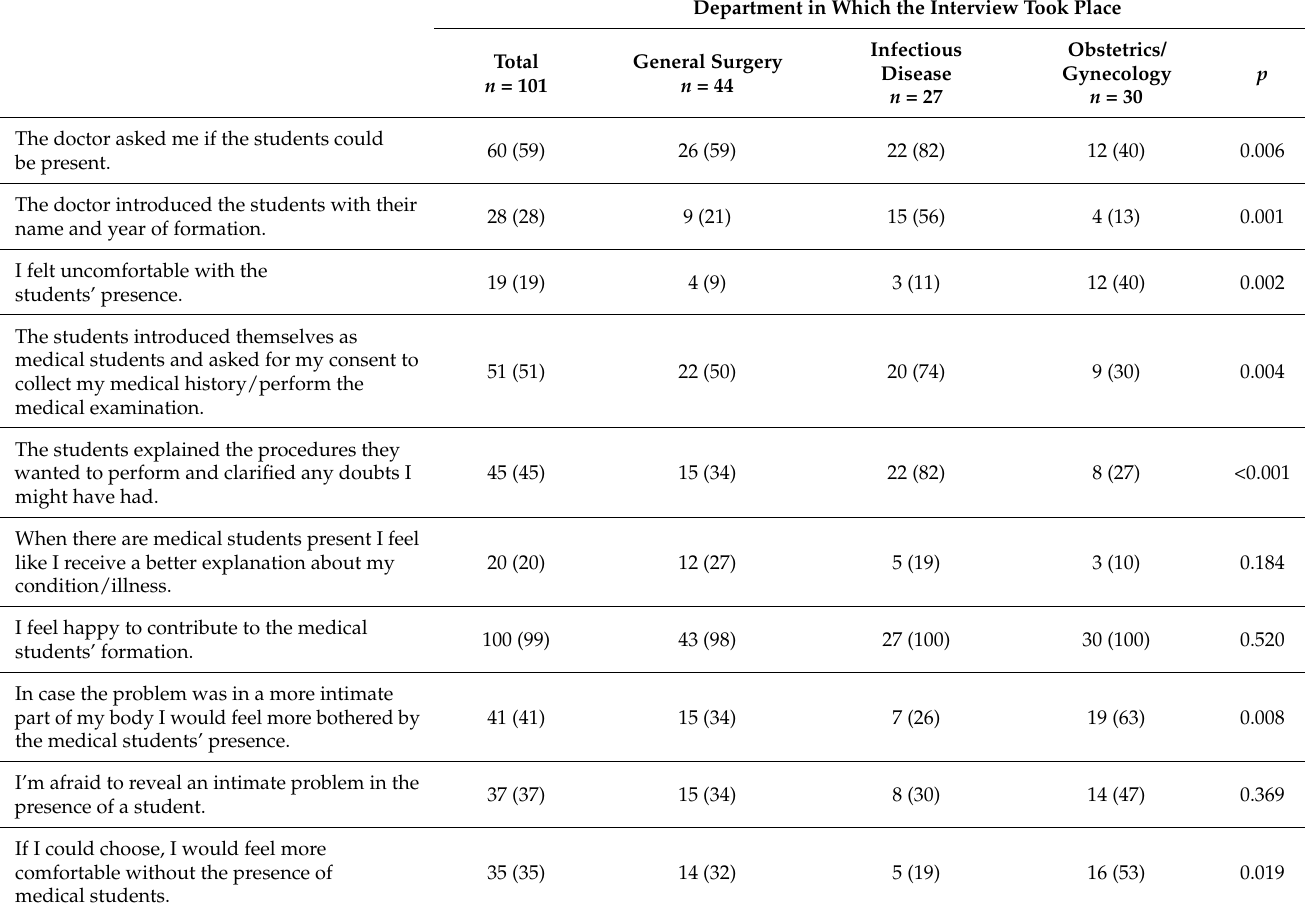
Table 2. n (%), of answers to the questions regarding the presence of medical students on a previous consultation and/or hospital admission according to the department where the interview took place. Department in Which the Interview Took Place Total General Surgery n = 101 n =